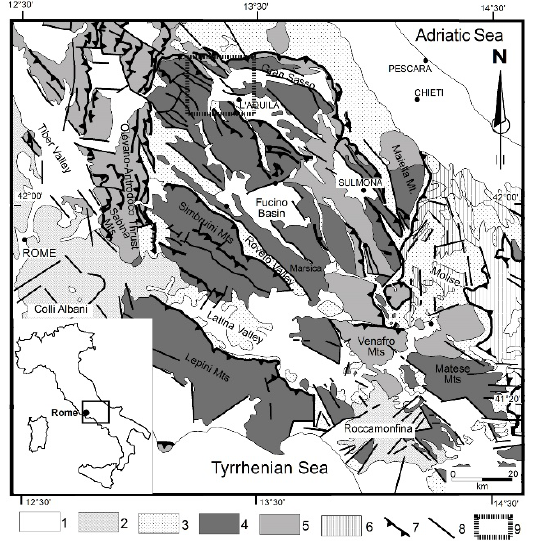
Fig. 1: Simplified geological and structural map of the central Apennines. Legend: 1) Marine and continental clastic deposits (Pliocene–Quaternary); 2) Volcanic deposits (Pleistocene); 3) Synorogenic hemipelagic and turbiditic sequences (Tor- tonian–Pliocene); 4) Carbonate platform deposits (Triassic– Miocene); 5) Slope and pelagic deposits (Lias–Miocene); 6) Molise–Sannio pelagic deposits (Cretaceous–Miocene); 7) Main thrust fault; 8) Main normal and/or strike-slip fault; 9) Black dashed rectangle define the study